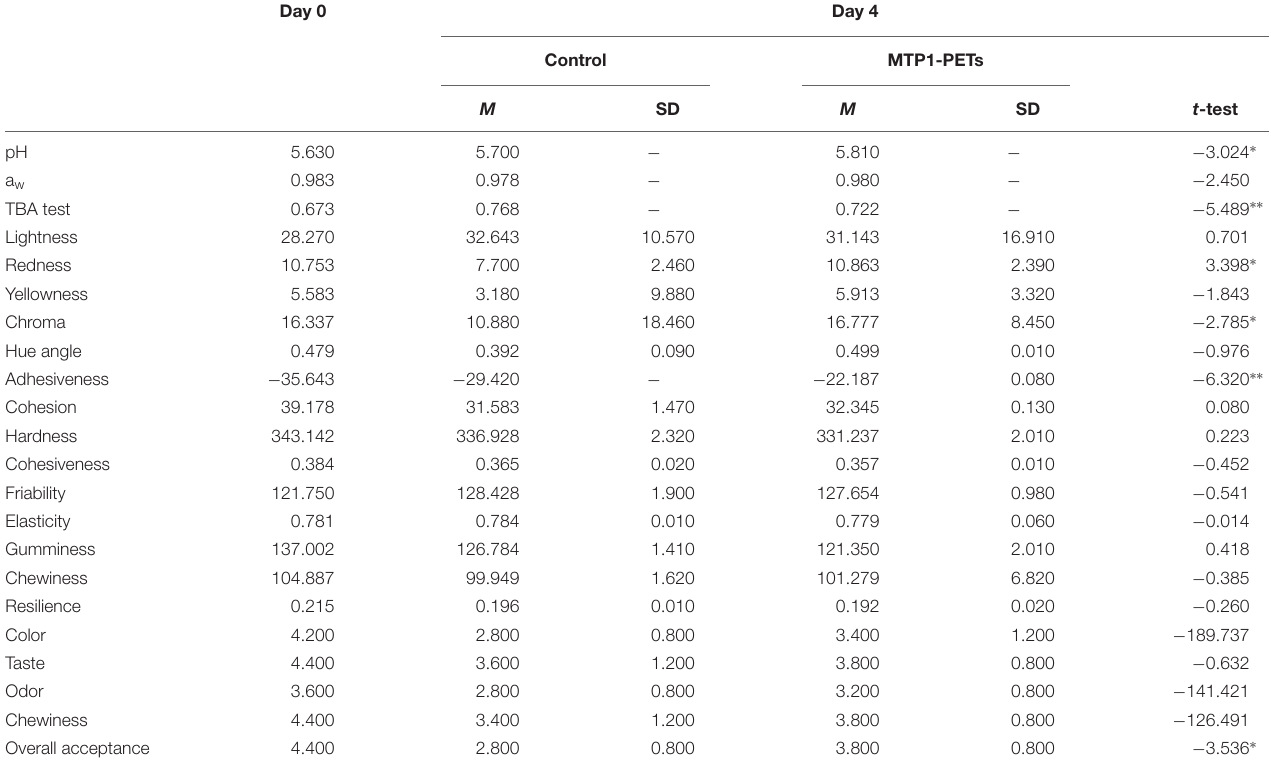
TABLE 1 | Effects of MTP1-PETs on physical–chemical (pH, a w , and TBA test), rheological parameters (color and texture), and sensory evaluation of buffalo meat samples.